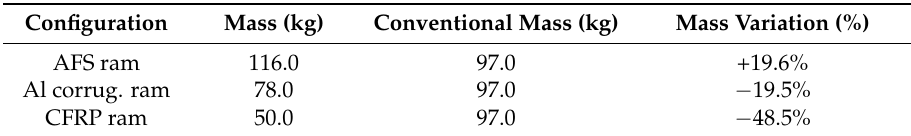
Figure 4. FE model of AFS structure: the deformed shape ( μ m) in the X orientation ( a ) and in Y orientation ( b ), applying a static load of 60 N at tool tip point. Table 3. The structure mass